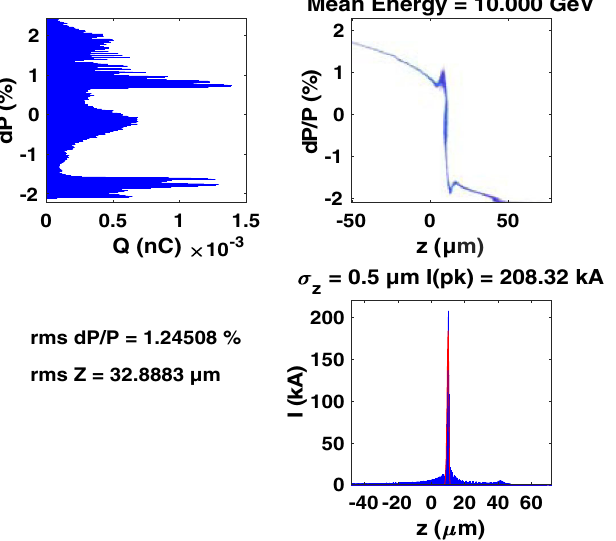
FIG. 4. Longitudinal phase space of the 2-nC electron bunch tracked to sector 20 at maximum compression.